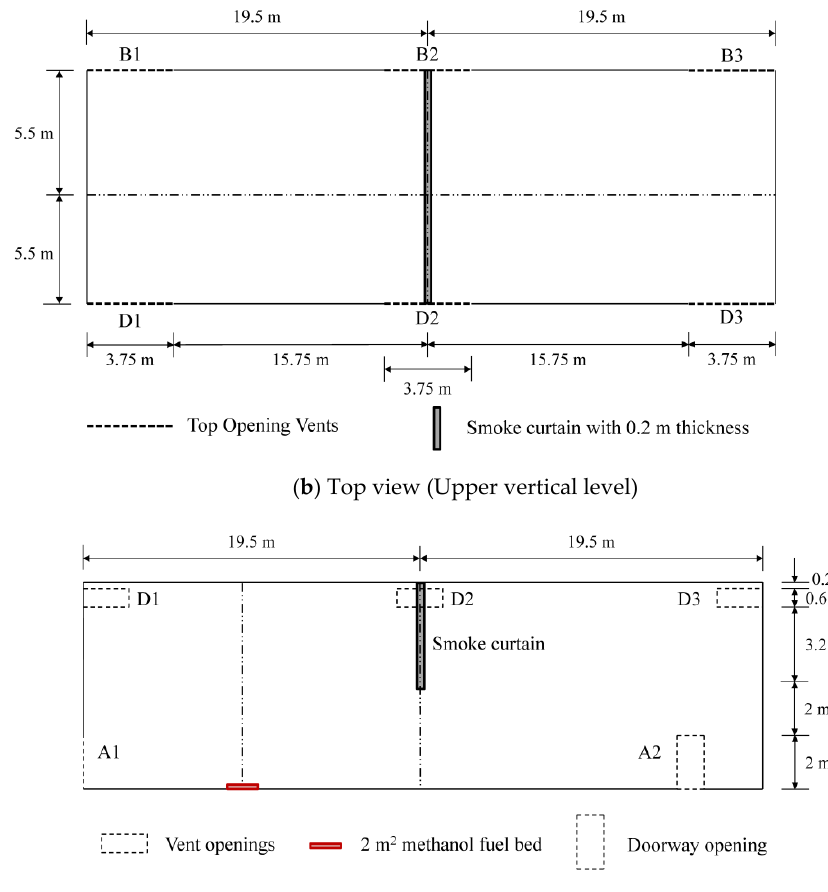
Figure 1. Configuration of the large atrium for Configuration 1 (no smoke curtain), ( a ) Top view at the lower level, showing the locations of the fuel bed, doorway openings, and thermal couple trees, ( b ) Top view at the upper level, showing locations of the top opening vents and smoke curtain ( c ) Side view showing the vent openings (figure modified after previous work [43]).